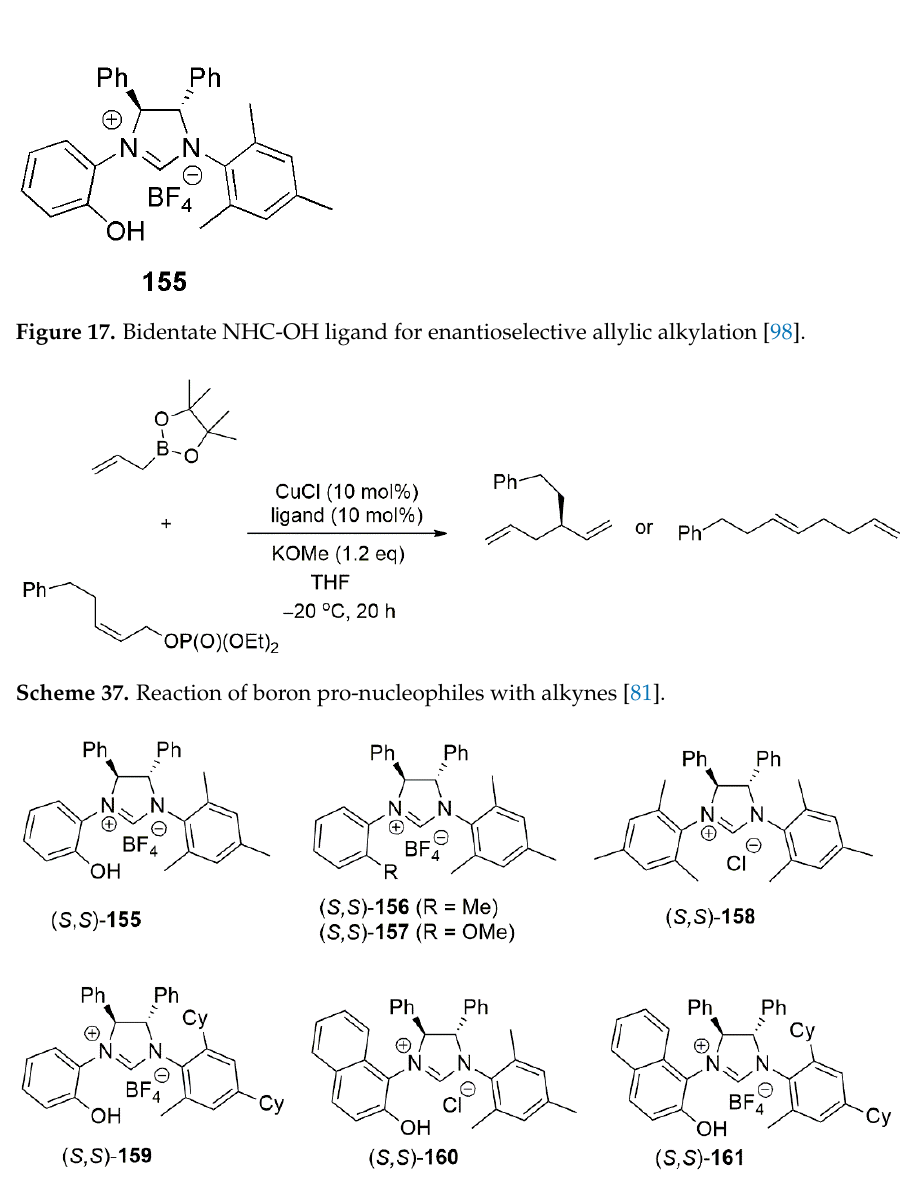
Scheme 37. Reaction of boron pro ‐ nucleophiles with alkynes [81].